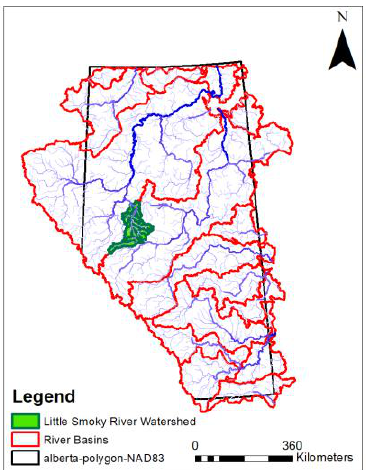
Figure 1. The study area (Little Smoky River Watershed), shown within the province of Alberta, Canada.